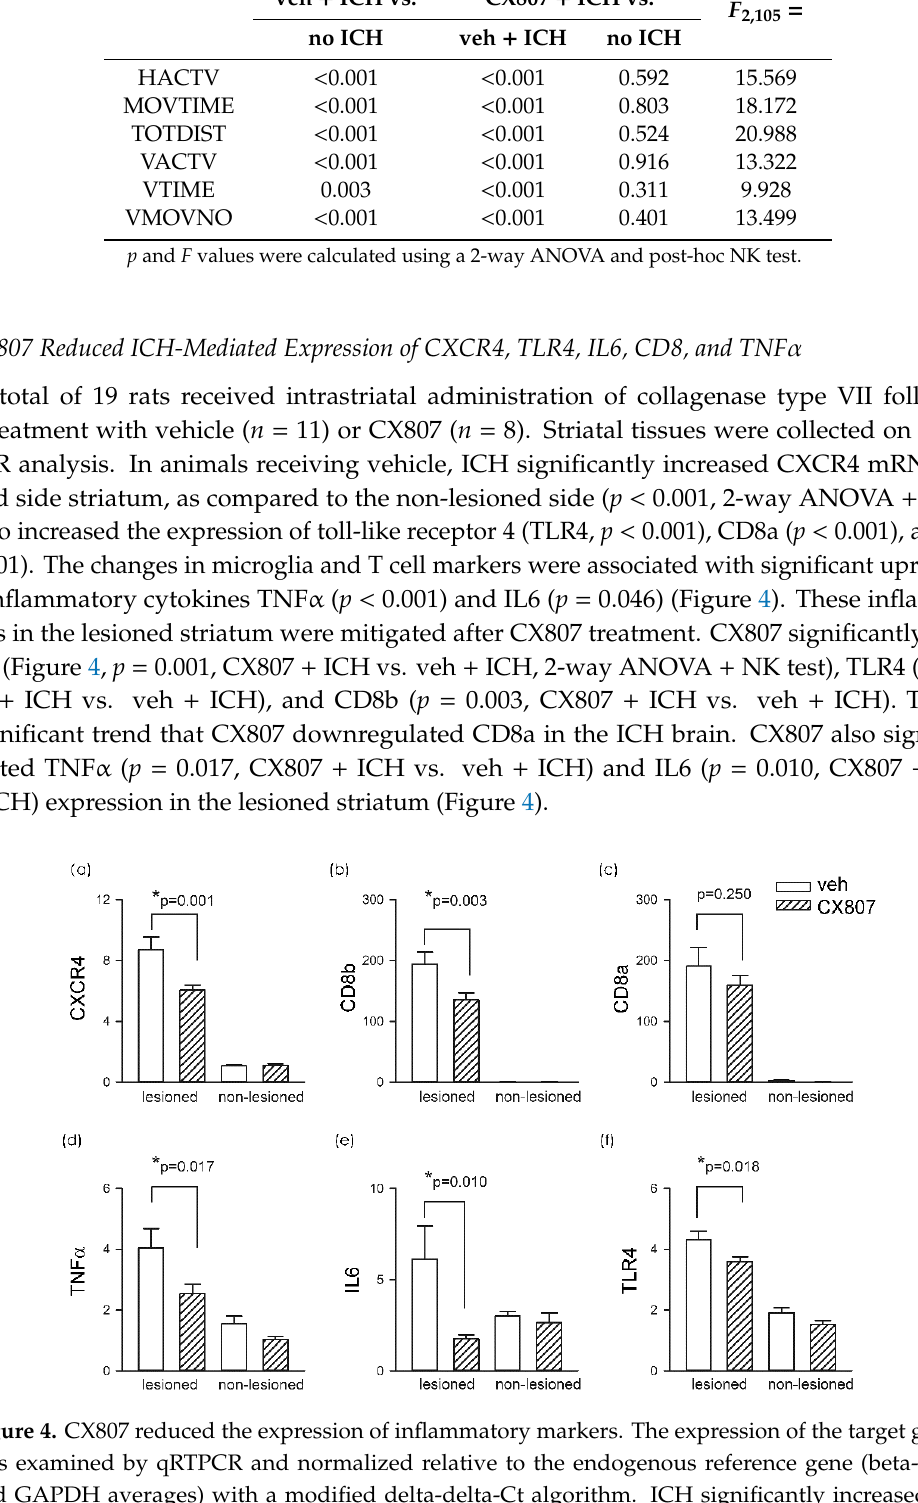
Table 1. Significant differences in locomotor behaviors amongst all